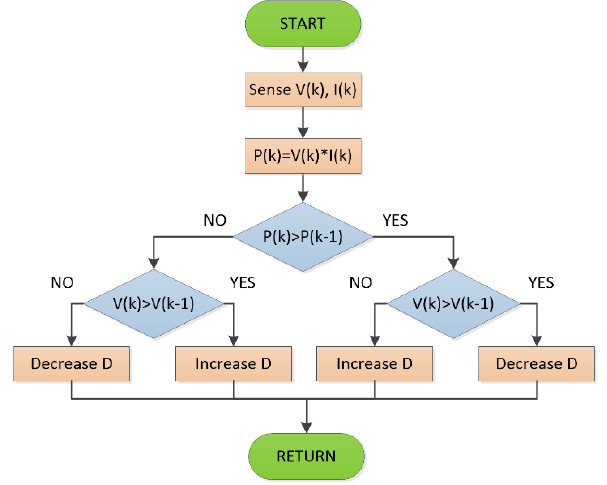
Figure 4. Perturb and Observe (P&O) control algorithm.